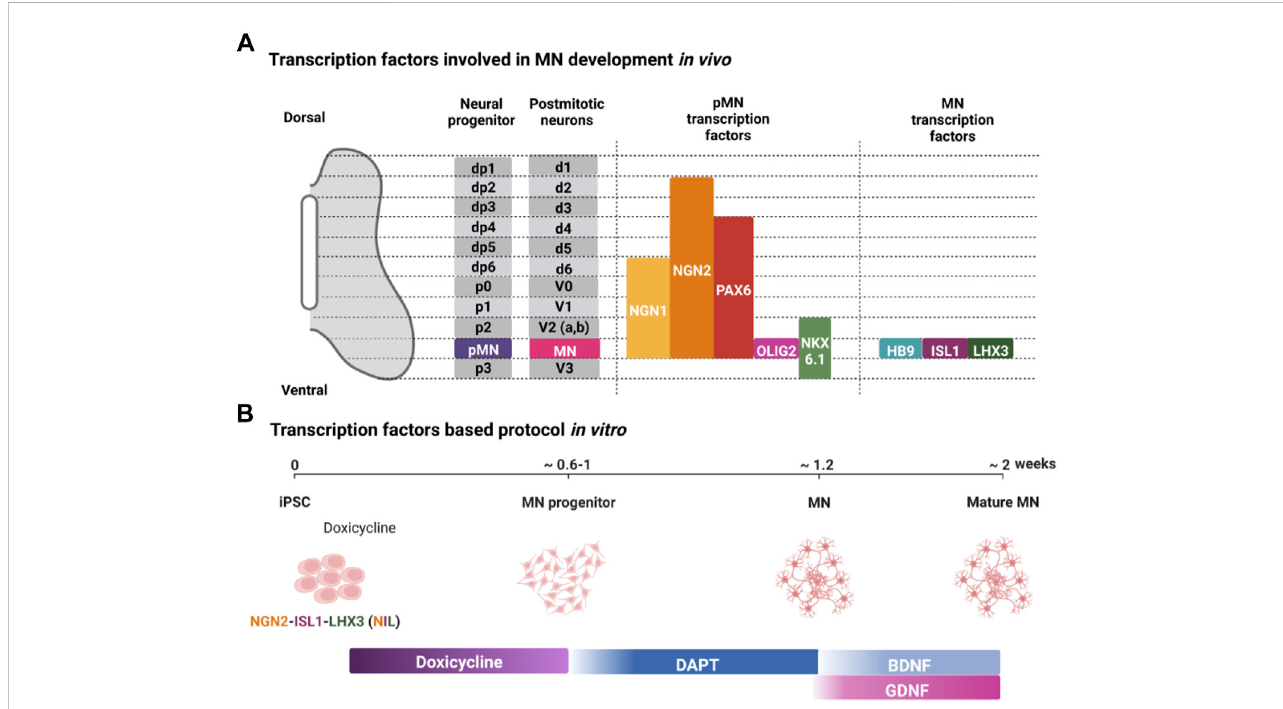
FIGURE 2 Transcription factors regulating MN development in vivo and their use in differentiating iPSCsinto MNs in vitro . (A) Transcription factors expressedin the MN progenitors (pMN) and post-mitotic MNs (MN) in the developing neural tube. (B) Representative protocol for using expression of speci fi c transcription factors to direct the differentiation of iPSCs into MNs. Created with BioRender.com.